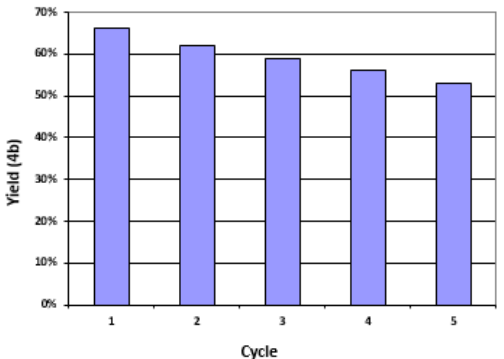
Figure 1. Reuse of ionic liquid [BMIM][PF 6 ] in the synthesis of 4b at room temperature.